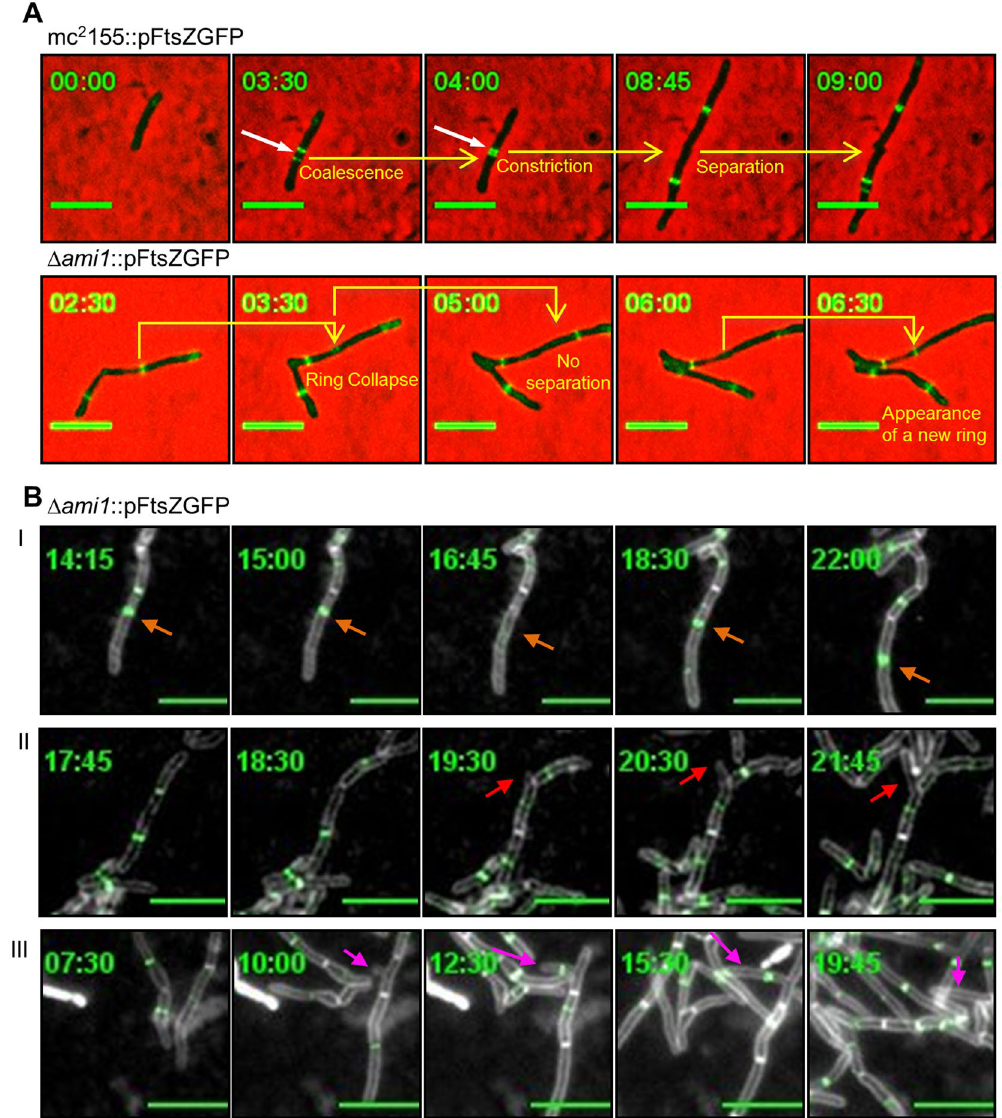
Figure 4. Time-lapse microscopic to assess the localization of FtsZ-rsEGFP. ( A ) M. smegmatis mc 2 155 and Δ ami1 cells were grown in Middlebrook 7H9 and subjected to time-lapse analysis to monitor FtsZ bundling and constriction, indicated by white arrows. In the Δ ami mutant, FtsZ is able to form rings, but these eventually collapse. ( B ) Time-lapse microscopic to assess the localization of FtsZ-rsEGFP in cells stained with FM4- 64. Cells were grown in Middlebrook 7H9 and stained with FM4-64 during time lapse analysis. White color indicates FM4-64 staining. Depicted in panel I is the formation of FtsZ rings in a single cellular compartment, followed by collapse and repolymerization. In panel II, FtsZ rings bundle in two connected daughter cells, but these do not coalese at the septum instead, failure to separate leads to the formation of a lateral bud at the septum (red arrows). In panel III, failure to separate leads to the formation of a lateral bud, not located at the septum, with subsequent formation of a FtsZ ring in the lateral bud (magenta arrows). Scale bar = 5 µ m. Time frame is in